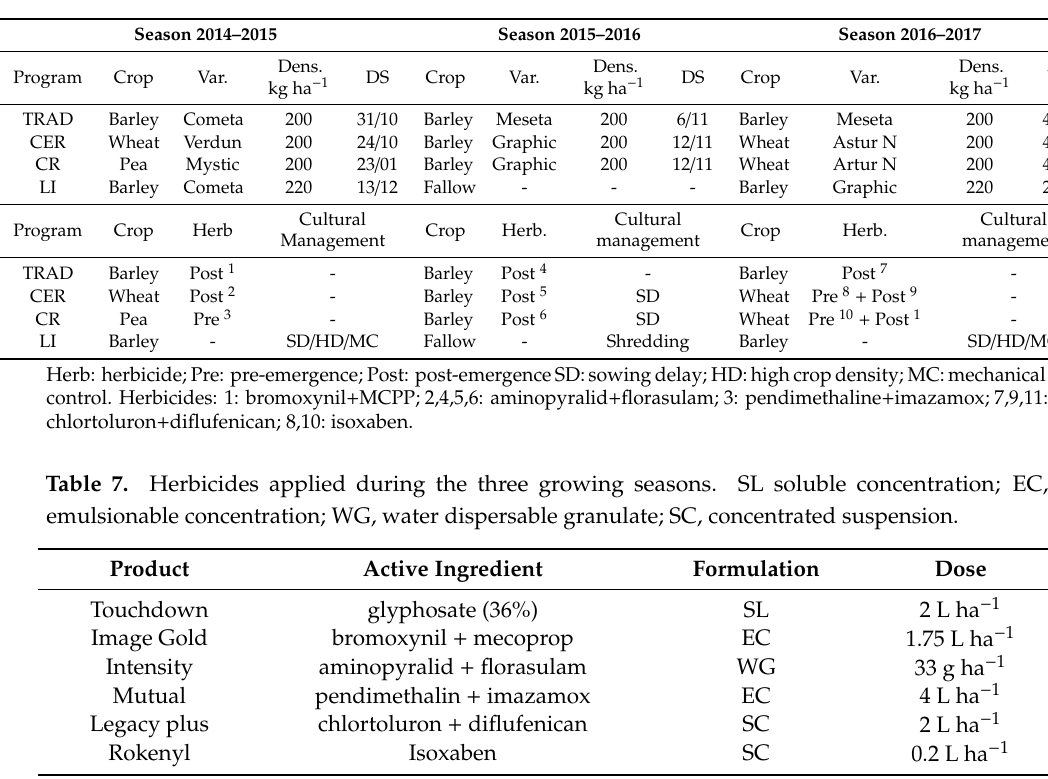
Table 6. Characteristics of each management program and season: TRAD, barley monocrop with post emergence application of herbicides; CER, wheat-barley rotation with pre and post emergence application of herbicides; CR, crop rotation (pea-barley-wheat) with chemical and cultural management; LI, low input non-chemical management. See text for more details. Var.: variety; Dens: crop density; DS: date of sowing. Var: variety; Dens: crop density; DS: Date of sowing.